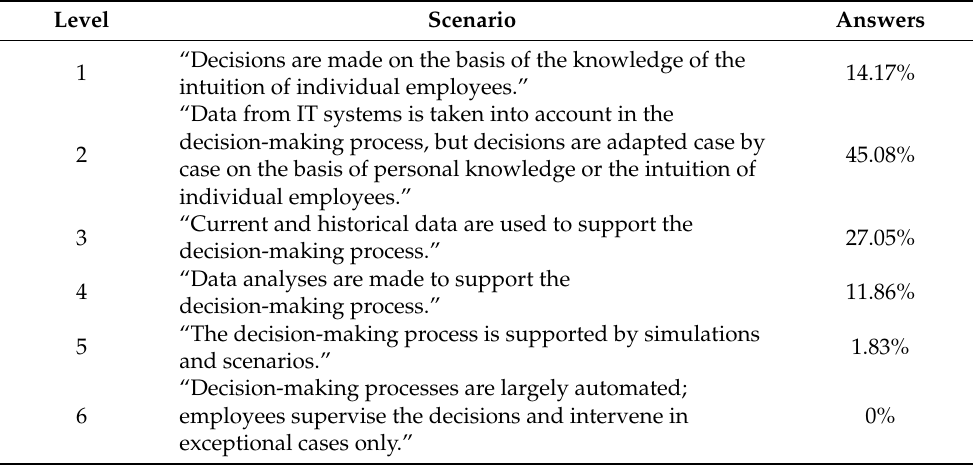
Table 8. Results for the capability “Data-based decision